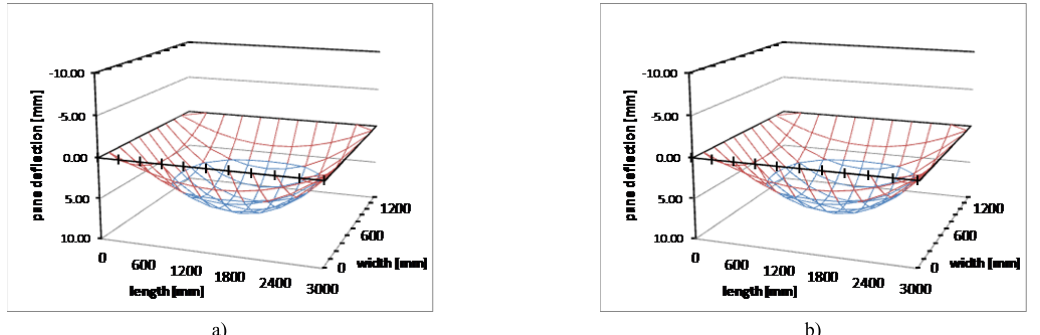
Fig. 13 Deflection of IGU glass panes (1500 x 3000 mm) with Ködispace 4SG spacer, a) ext. pane, b) int.